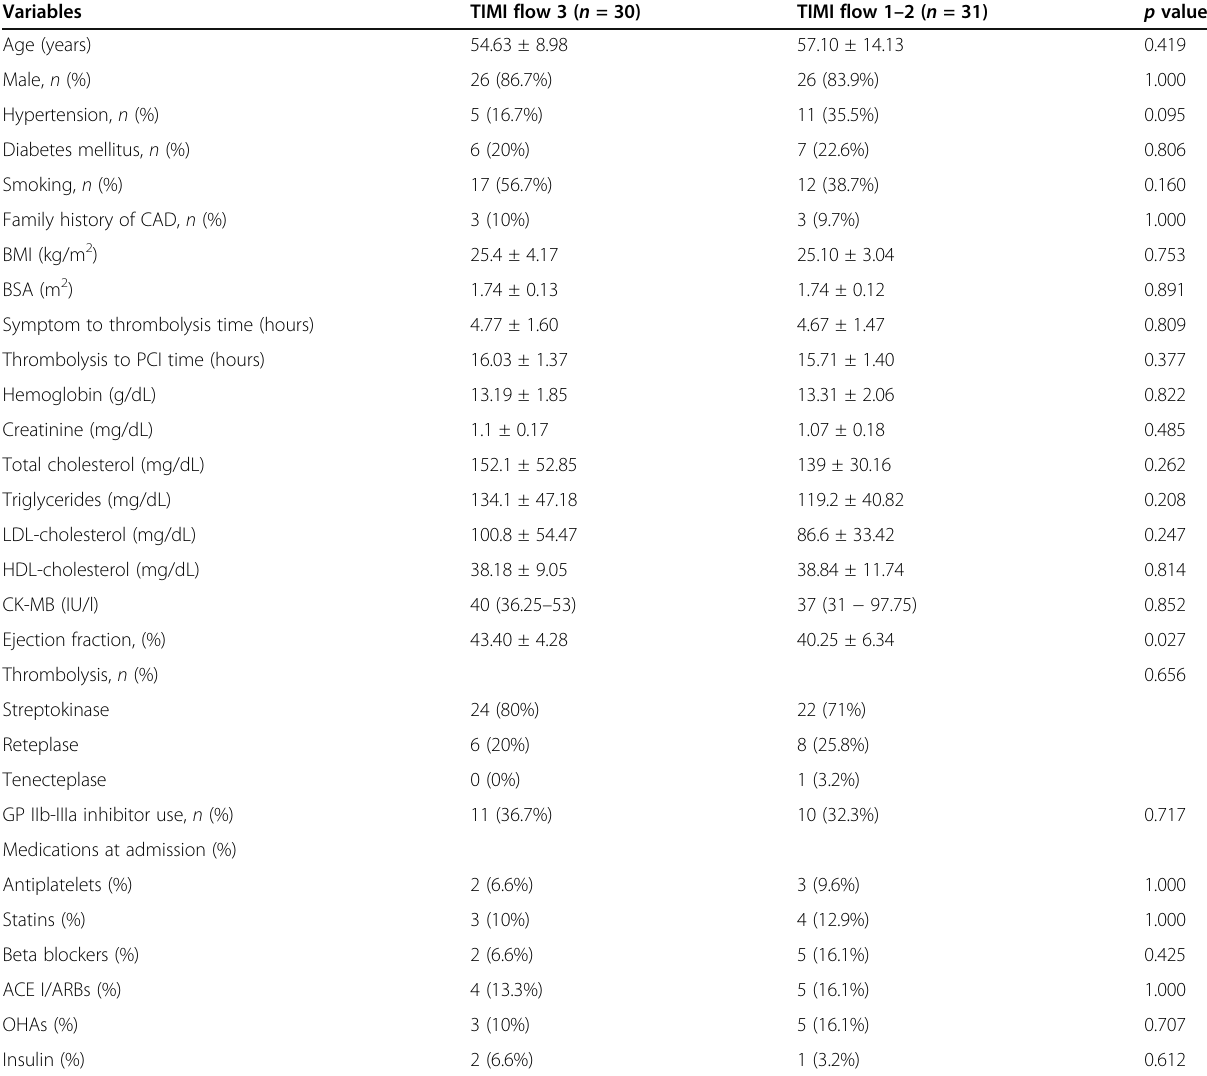
Table 1 Baseline characteristics of the patients ( n = 61)